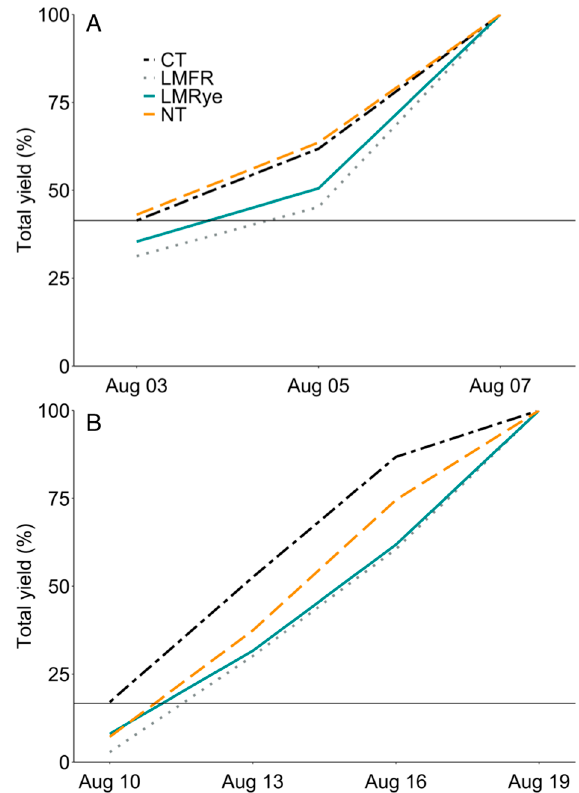
Figure 4. Percent of total sweet corn yield harvested on each sample date in 2020 ( A ) and 2021 ( B ) in conventional till (CT), no-till (NT), living mulch + forage radish residue (LMFR), and living mulch + rye residue (LMRye). Horizontal line marks the initial yield in CT.